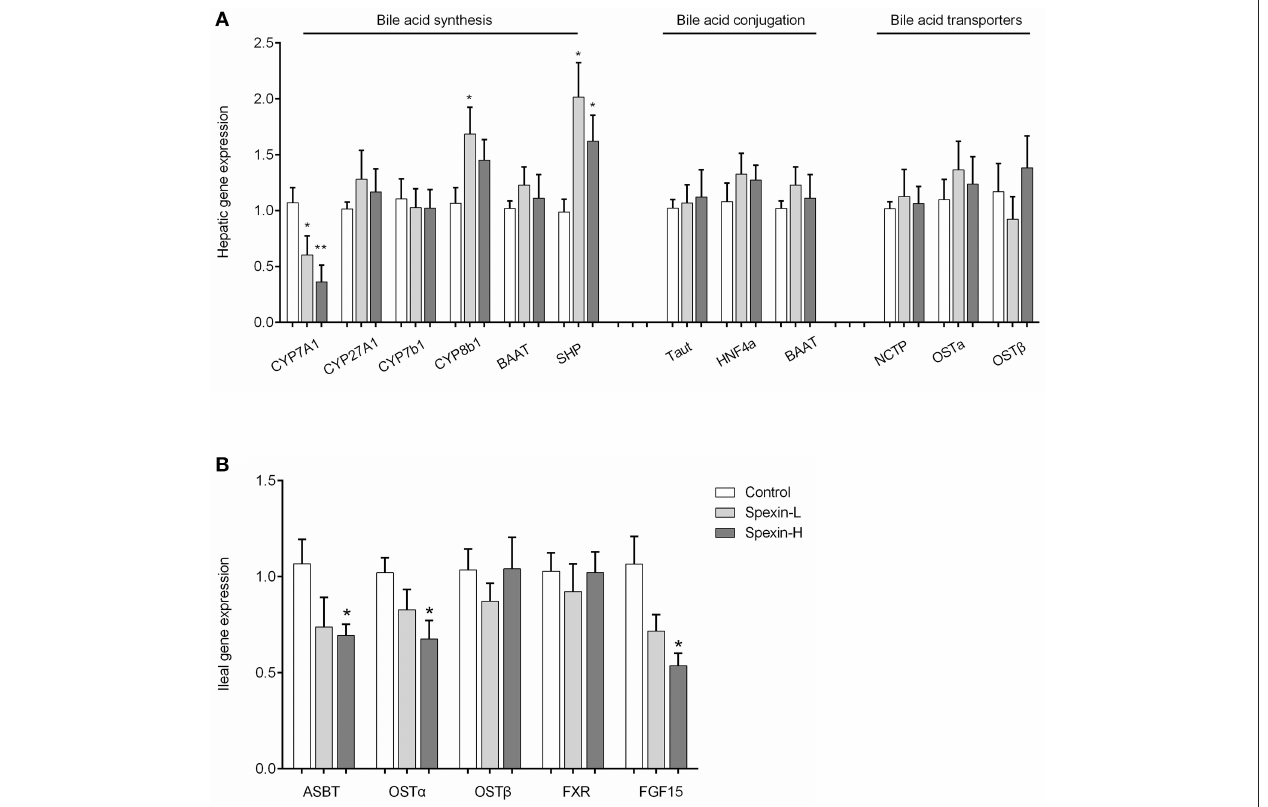
FIGURE 5 | Spexin regulation of genes involved in bile acid synthesis, conjugation, transportation and reabsorption . Gene expression of enzymes involved in bile acid biosynthesis, conjugation, and bile acid transporters in the liver (A) , and genes involved in bile acid reabsorption in the ileum (B) were quantified by Real-time PCR. Control ( i.p. injection with saline); Spexin-L ( i.p. injection with 12.5 µ g/kg spexin); Spexin-H ( i.p. injection with 25 µ g/kg spexin). Results are shown as Mean ± SEM ( n = 10/group). * p < 0.05 and ** p < 0.01 vs. control resulting from Student’s t